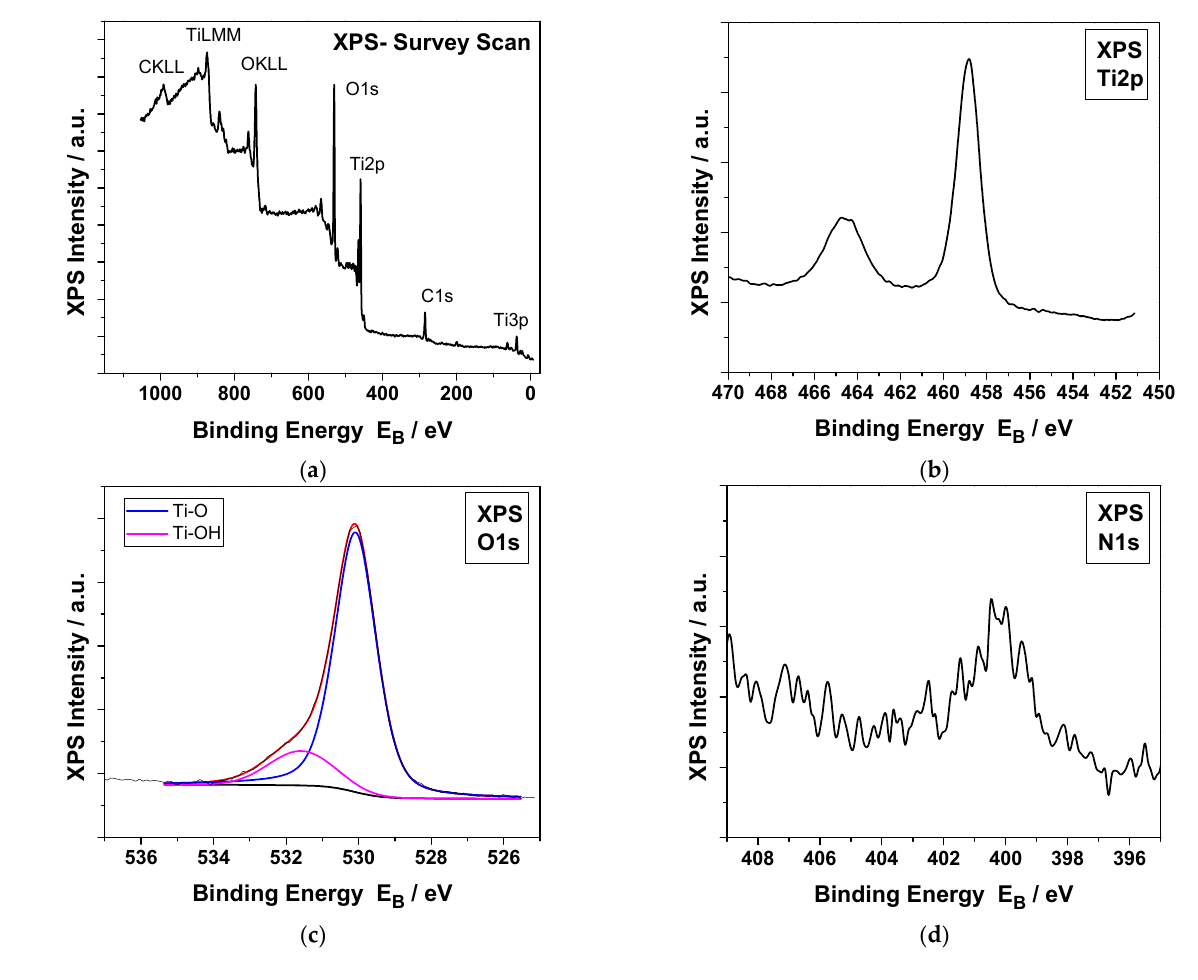
Figure 3. XPS spectra of N-TiO 2 particles: ( a ) survey scan, ( b ) high resolution of Ti2p peak, ( c ) high resolution of deconvoluted O1s peaks, and ( d ) high resolution of N1s peak.